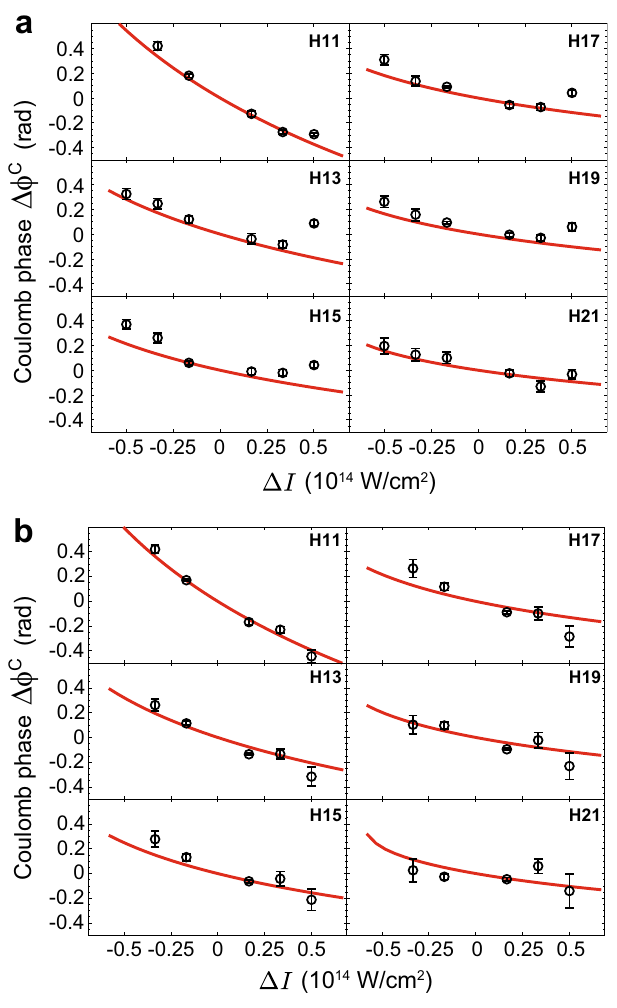
Figure 3. Differential phase measurements of the Coulomb phase. (a,b) Measured (black symbols) and calculated (red lines) Coulomb phase as a function of intensity variation in argon (a) and nitrogen (b) . In both the measurements and the calculations, we subtract the strong-field phase from the phases presented in Fig.